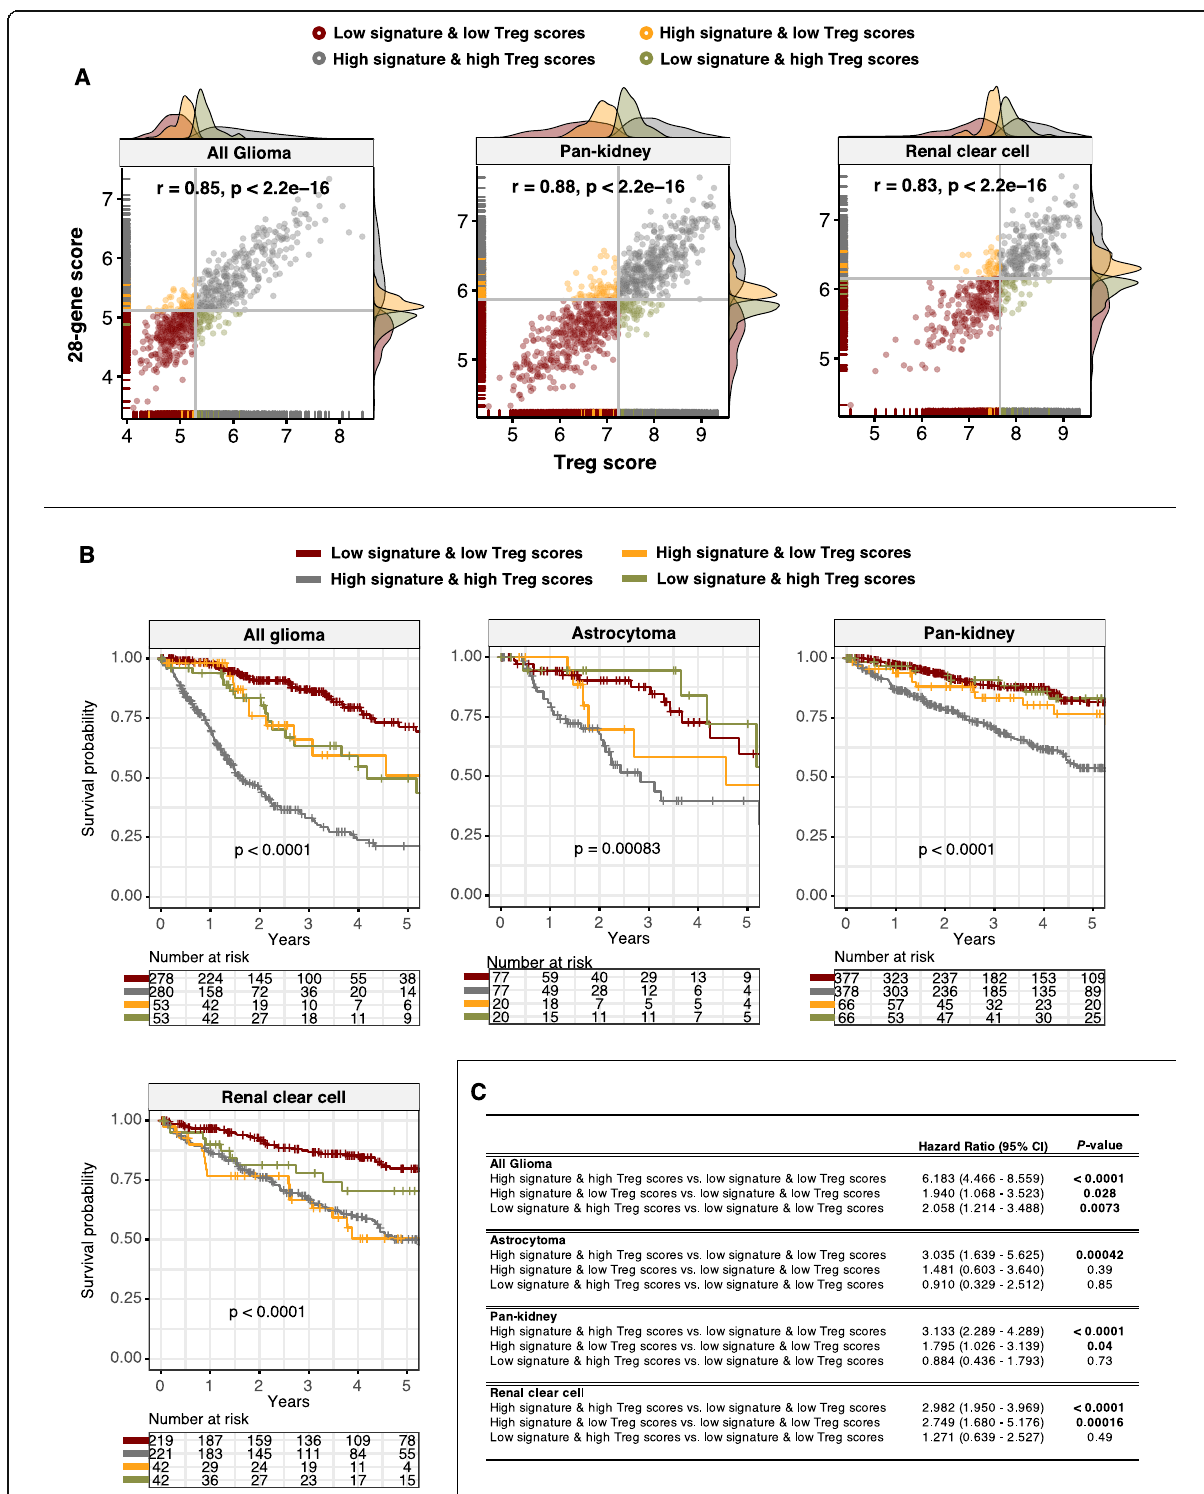
Fig. 6 (See legend on next